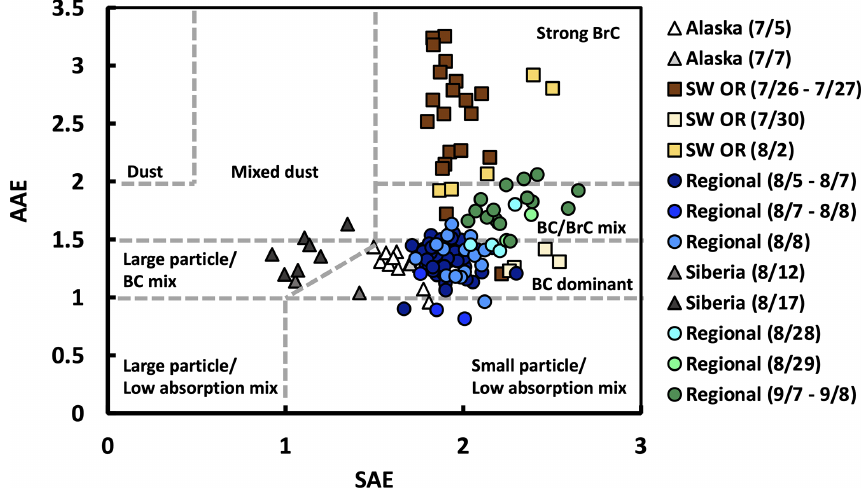
Figure 3. 1h average SAE and AAE values plotted for all BB events (July–September 2019) observed at MBO, with classification categories from Cappa et al. (2016). SAE describes particle sizes, with small values indicating large sizes, and AAE describes particle composition, with larger values indicating greater BrC content. BB events are colored by the source, with boreal (Alaska, Siberia) shown as triangles in shades of grey, SW OR shown as squares in shades of brown, and regional shown as circles in shades of blue to